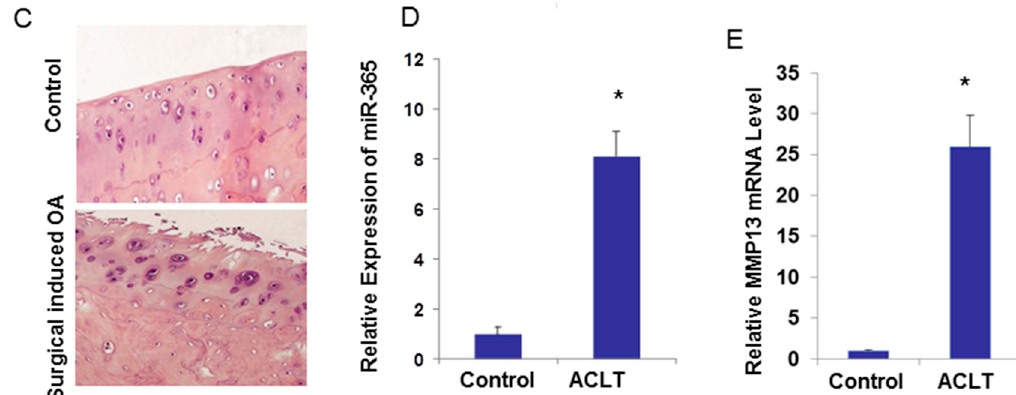
Figure 3. Expression of miR-365 is elevated in articular chondrocytes and experimental osteoarthritis (OA) rats. ( A ) miR-365 expressed at a higher level in OA chondrocytes compared with normal chondrocytes (Control). OA chondrocytes were isolated from cartilage of a 62-year-old OA patient undergoing total knee arthroplasty. Normal control chondrocytes were isolated from 26-year-old male patient undergoing amputation because of trauma; ( B ) The expression level of MMP13 was analyzed by real-time PCR. n = 3, * p < 0.05; ( C ) Cartilage degradation in anterior cruciate ligament transection (ACLT) surgery induced OA model in rats. Tissue section was stained with H&E staining; ( D , E ) miR-365 expression and MMP13 were significantly induced in the cartilage from anterior cruciate ligament (ACL) surgery mice compared with cartilage from sham operated leg (Control). Rat joint cartilage tissues were analyzed by TaqMan miRNA assay for miR-365 expression ( D ) and by SYBR Green real-time polymerase chain reaction for MMP13 mRNA expression ( E ). Results are the mean ± SD, n = 6, * p < 0.05.